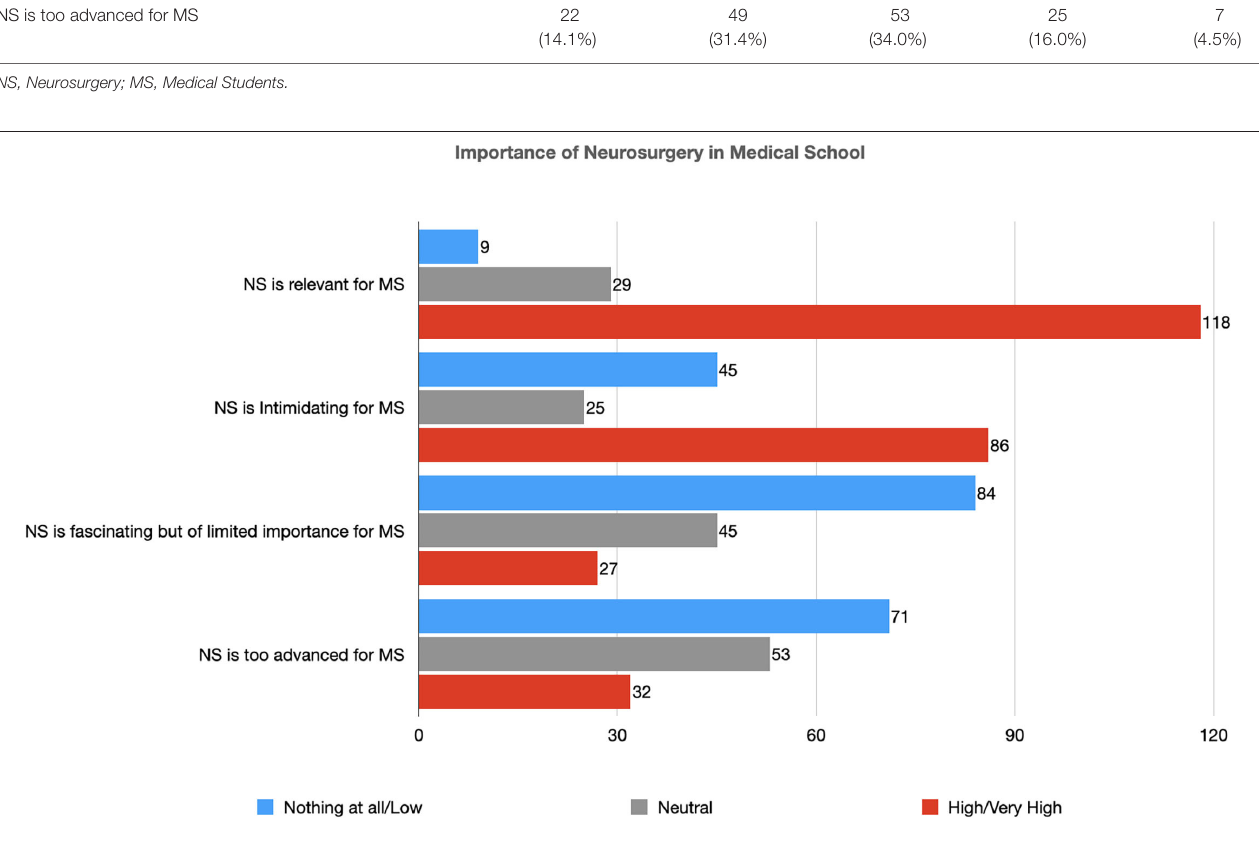
FIGURE 2 | Importance of neurosurgery in medical school (NS, Neurosurgery; MS, Medical